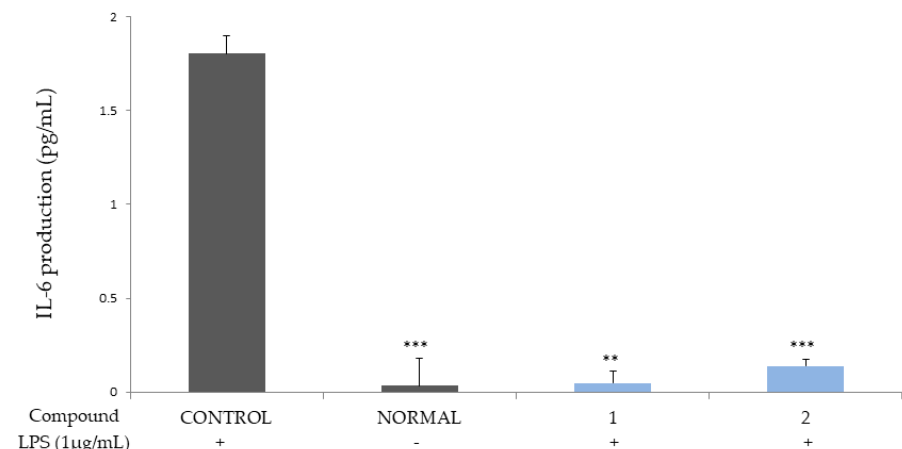
Figure 2. Inhibitory activities of compounds 1 and 2 on IL-6 production in the THP-1 macrophage cell. Control, compounds 1 and 2 were added LPS (1 μg/mL). Normal was not added LPS. Values are expressed as the means ± standard deviation (SDs) from triplicate measurements. * p < 0.05, ** p < 0.01, and *** p < 0.001.